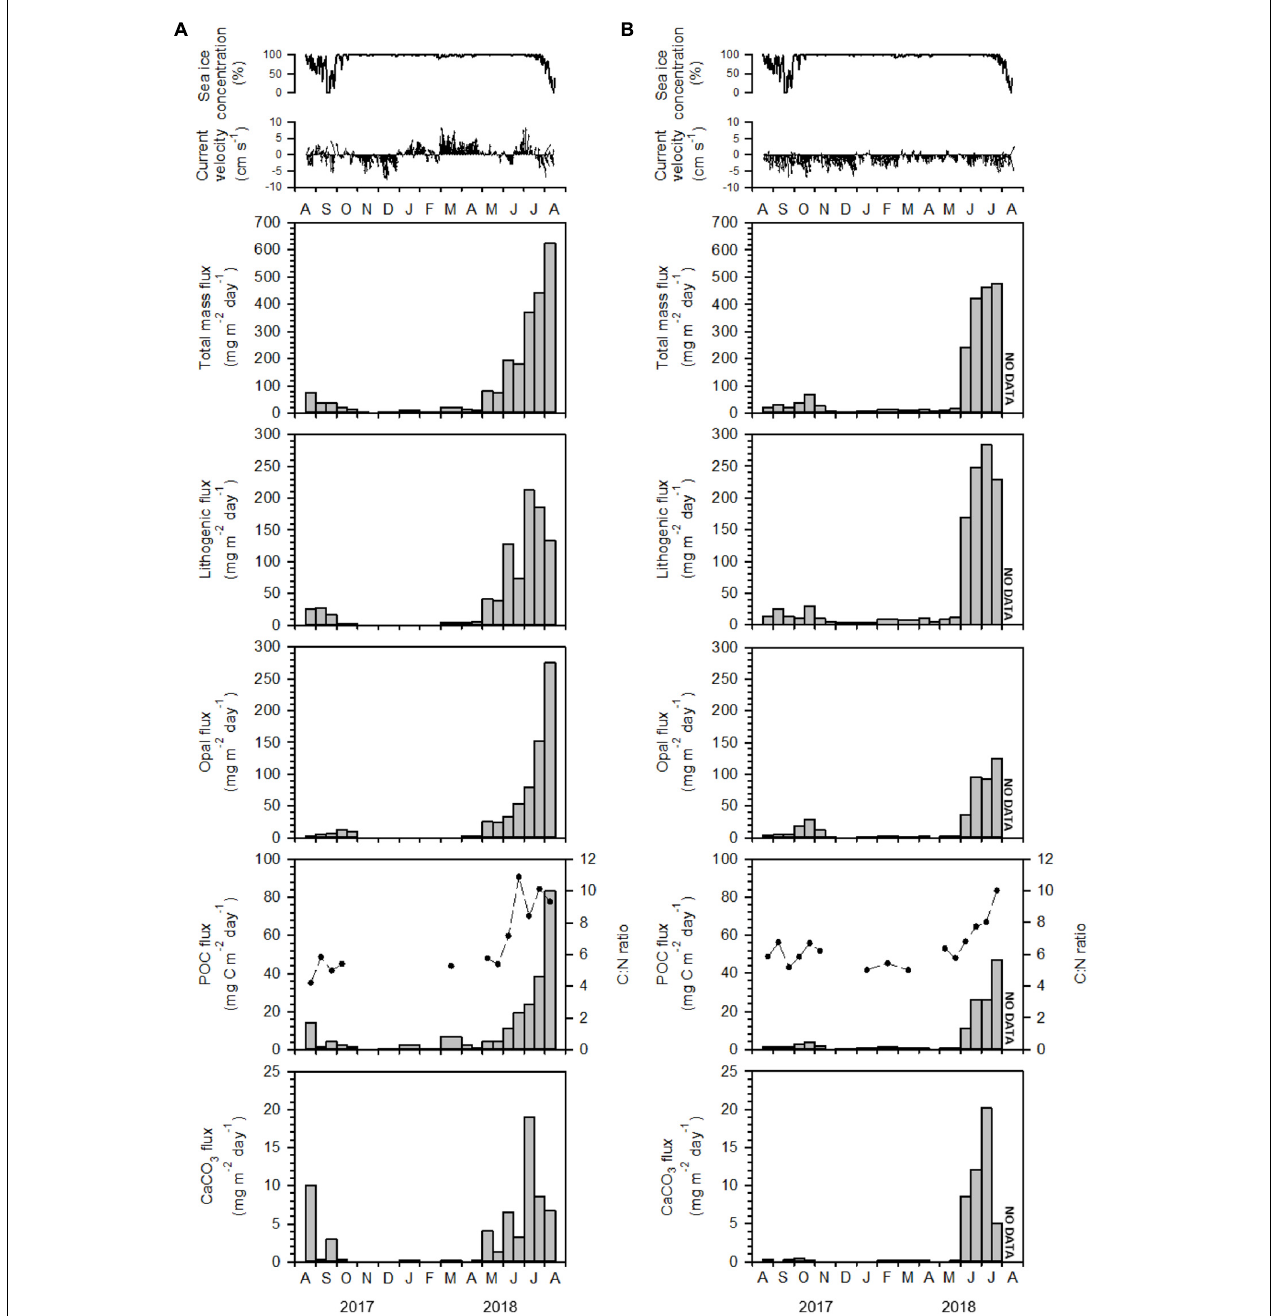
2.98 cm s − 1 ; in contrast, at 307 m, flow was steadily